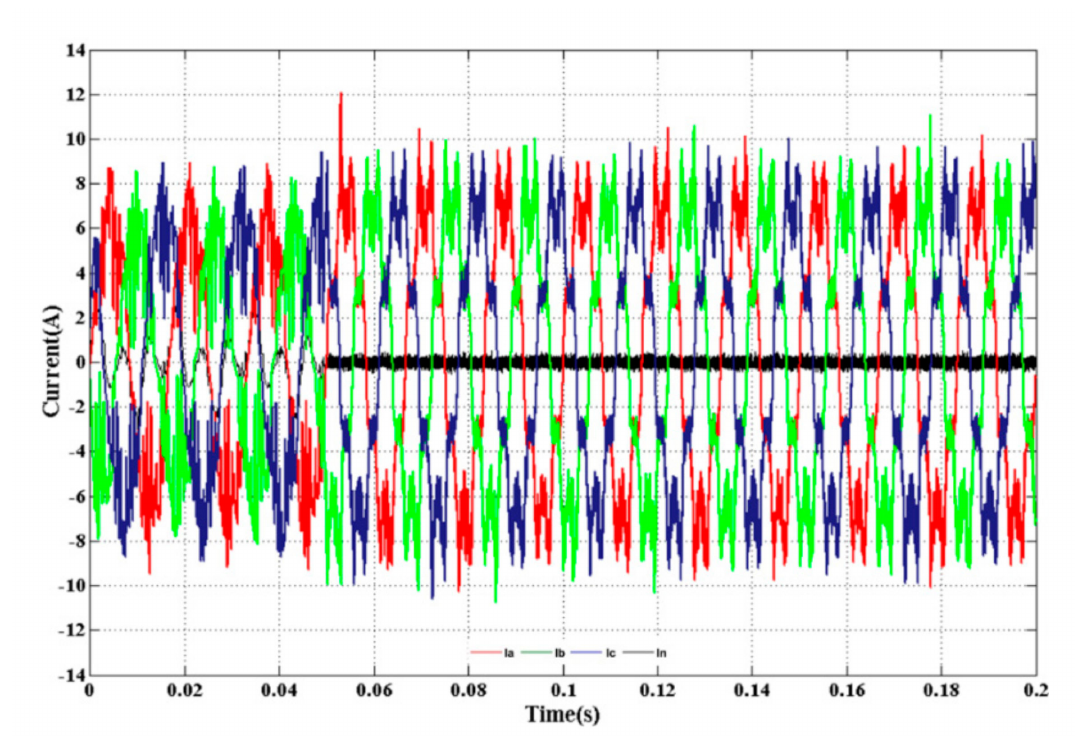
Figure 17. Experimental result of the traditional p-q method for case 3.